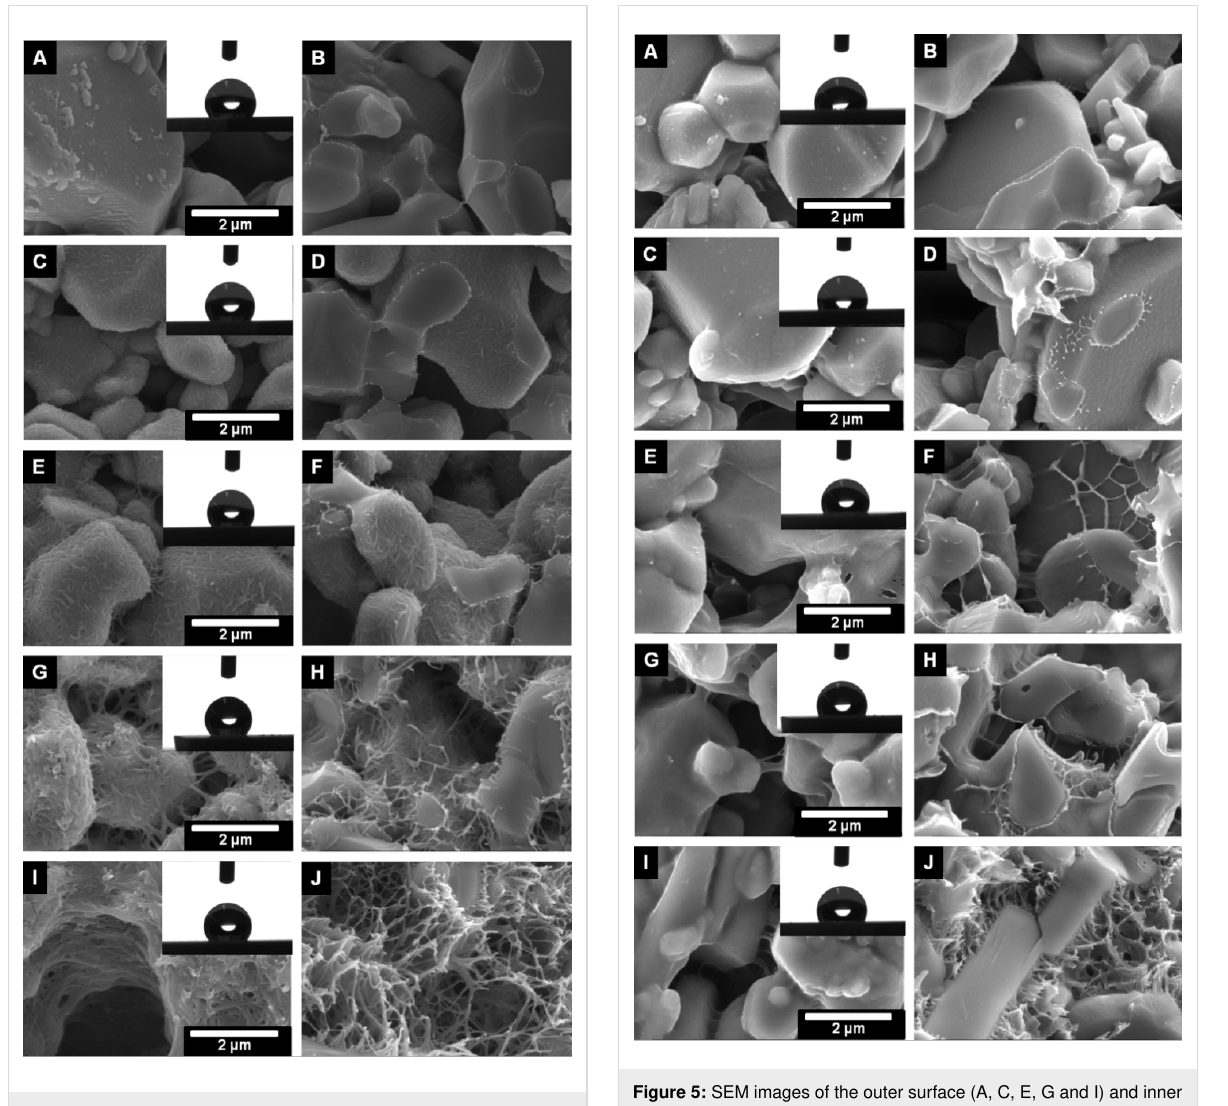
Figure 4: SEM images of the outer surface (A, C, E, G and I) and inner surface (B, D, F, H, J) of the polyphenylalanine functionalized ALOX- membranes from solvent mixture with 0 vol % (A and B), 50 vol % (C and D), 75 vol % (E and F), 90 vol % (G and H) and 100 vol % (I and J). Inserts represents the water contact angle (2 µL drop size).